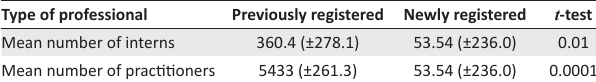
TABLE 3: Comparison between the transitional number of South African interns, practitioners and newly registered practitioners from 2008 to 2018. Type of